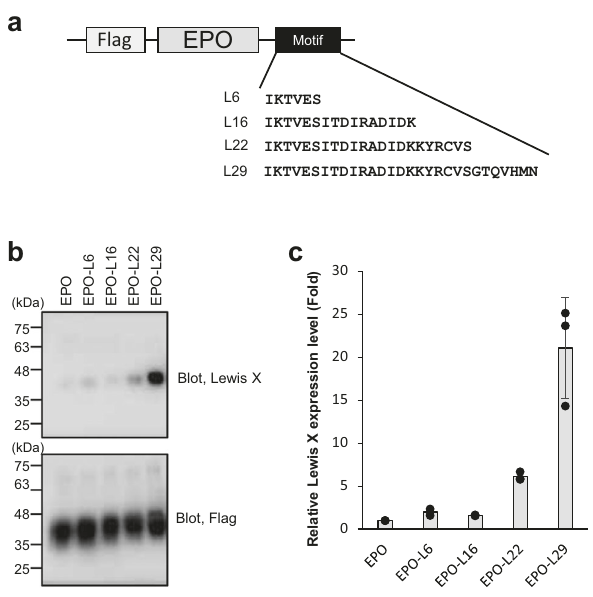
Fig. 4 FUT9-dependent Lewis X modi fi cation of EPO tagged with a LAMP-1-derived peptide. a Schematic representation of a model glycoprotein, EPO, containing various lengths of amino acid sequence segment derived from LAMP-1. b Lewis X expression on 3xFlag-tagged EPO analyzed by immunoblotting using anti-Lewis X and anti-Flag antibodies. c The density plot (Lewis X/Flag) of relative Lewis X expression levels normalized by Lewis X expression level on 3xFlag-tagged EPO. Error bars represent the SEM ( n = 3 independent experiments).